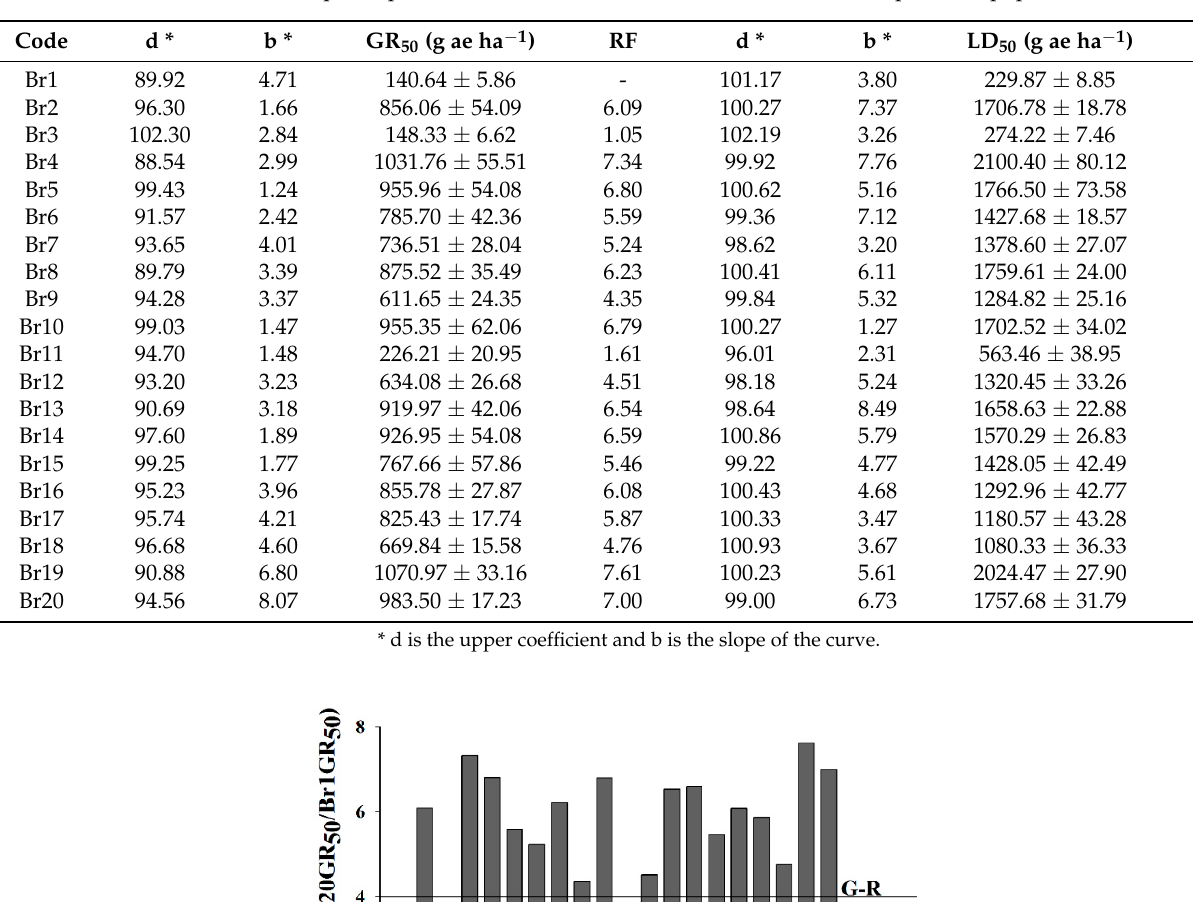
Table 3. Dose–response parameters of Bromus rubens resistant (R) and susceptible (S) populations.